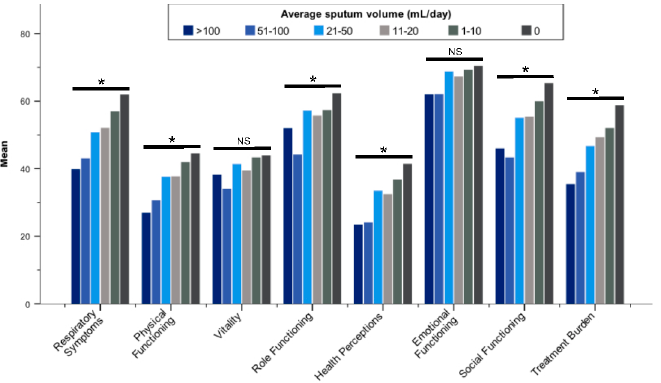
Figure 4. Mean Quality of Life-Bronchiectasis scores stratified by average daily sputum volume (categorized). Abbreviation: NS, not significant. * p ≤ 0.001; Differences between groups were assessed by the Kruskal–Wallis test. Table 5. Discrimination of QOL-B scores, stratified by Pseudomonas aeruginosa infection at baseline and/or in the previous 12